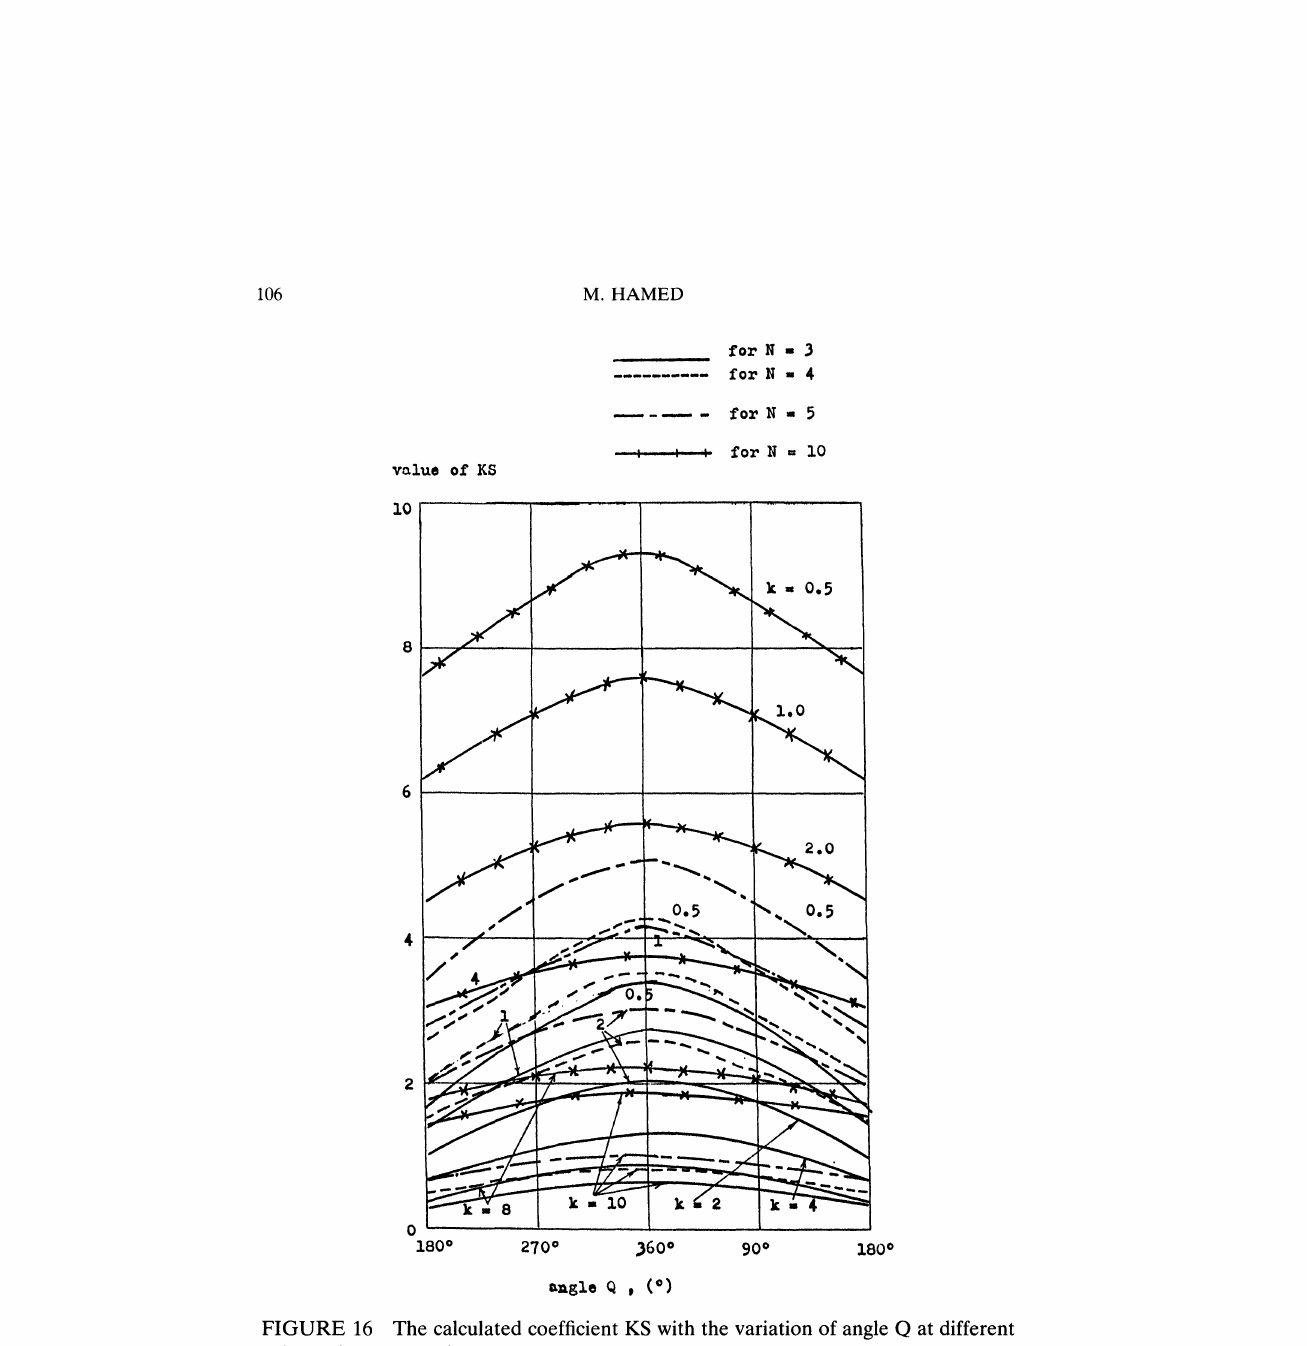
FIGURE 16 The calculated coefficient KS with the variation of angle Q at different values of current